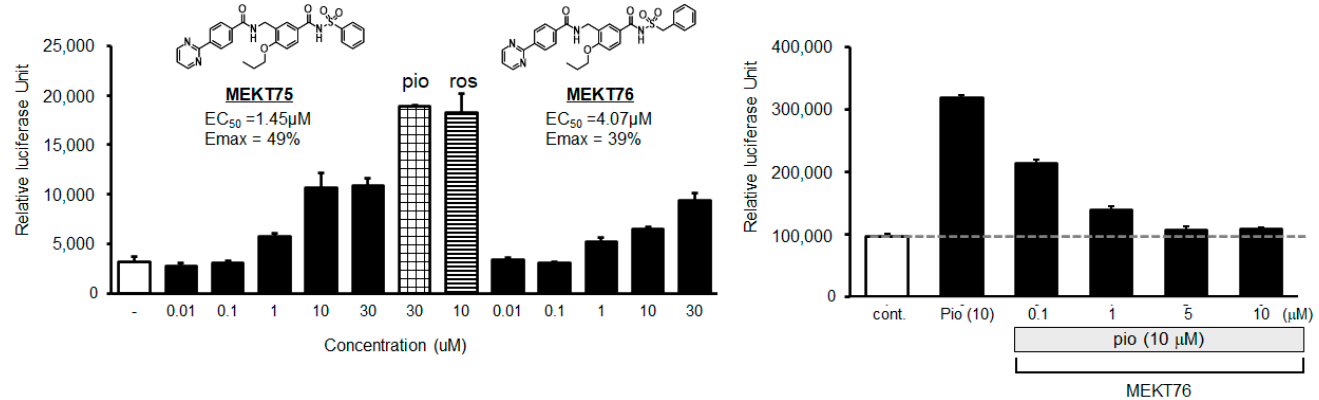
Figure 2. The transactivation and transrepression activities elicited by MEKT ‐ 75 and MEKT ‐ 76. ( Left ) Dose–response relationships of the hPPAR γ agonistic activities of MEKT ‐ 75 and MEKT ‐ 76. pio: pioglitazone. ros: rosiglitazone (hPPAR γ full agonists). ( Right ) Dose–response relationships for the hPPAR γ antagonistic activity of MEKT ‐ 76 in the presence of 10 μ M pioglitazone.